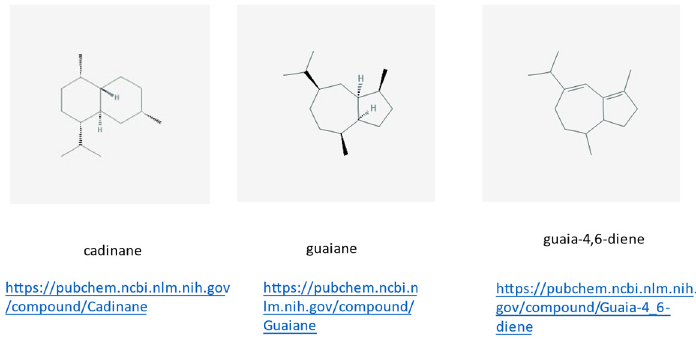
Figure 8. Three new cadinene- and guaiane-type sesquiterpenoids, all link accessed on 23 June